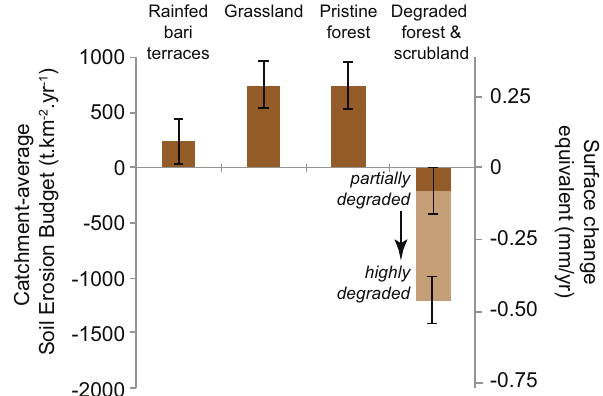
Figure 7. Net soil production/loss budget for different land use types in the Likhu Khola. Annual catchment-wide soil erosion bud- get based on inferred minimum soil production rates and mea- sured soil losses from plots (Gardner and Gerrard, 2001, 2003). Site-specific soil production (and erosional loss) is likely to be highly variable, so the budget shown here will not apply to all soils. Nonetheless, the net budget illustrates that some land uses such as well-maintained terraces may have minimal effects on soil degra- dation, while other land uses may lead to highly unsustainable soil